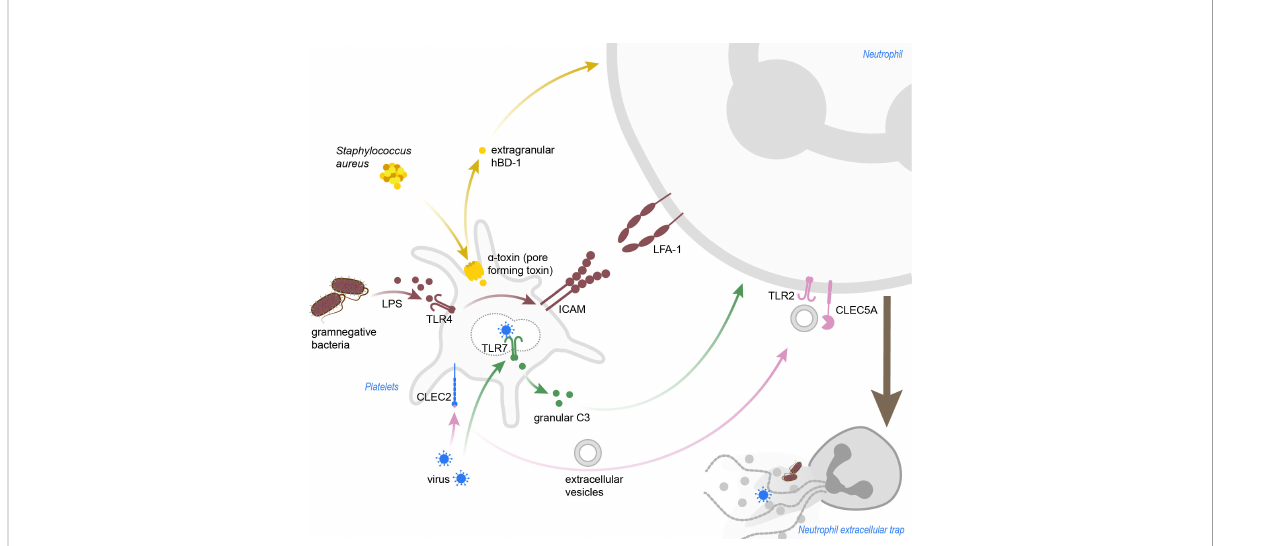
FIGURE 2 Pathogen-induced platelet-mediated NET formation. Staphylococcus aureus a -toxin induces pore formation in platelets, which then release hBD-1. Gramnegative bacteria and LPS activate platelets in a TLR4-dependent manner, and blocking of LFA-1 in this background abrogated NETosis in neutrophils. Dengue viruses can be sensed by platelets via CLEC2, which leads to shedding of extracellular vesicles promoting NETosis in a TLR2- and CLEC5A-dependent manner. Inlfuenza A virus are recognized via TLR7, and granular C3 then induces NETosis in neutrophils. C3, complement C3; CLEC2, C-type lectin-like receptor 2; CLEC5A, C-type lectin domain containing 5A; hBD-1, human b -defensin 1; ICAM, intercellular adhesion molecule; LFA-1, leukocyte function-associated antigen 1; LPS, lipopolysaccharide; TLR, toll-like